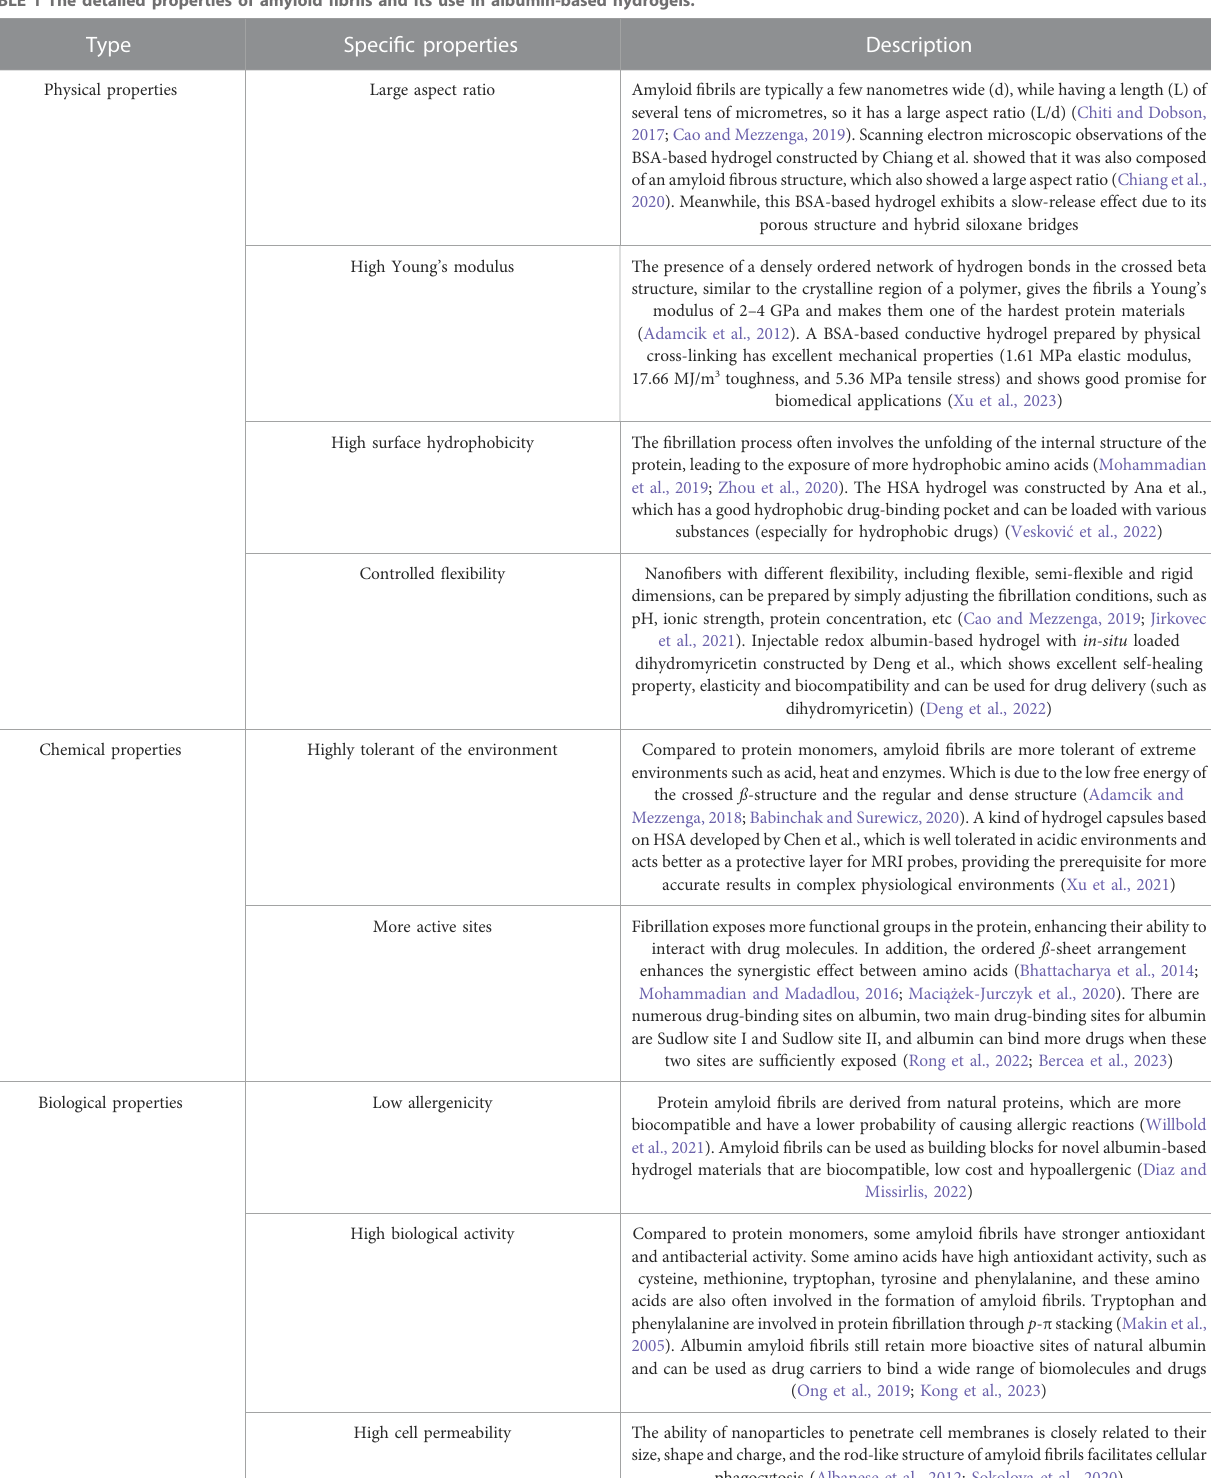
TABLE 1 The detailed properties of amyloid fi brils and its use in albumin-based